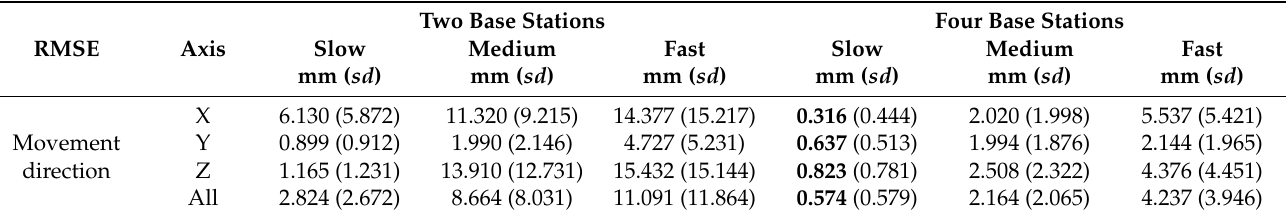
Table 4. Errors (mm) in tracking of translation with standard deviations ( sd ) during the conical spiral movement with different velocities: 12.5 mm/s (slow), 25 mm/s (medium), and 50 mm/s (fast). The best results are